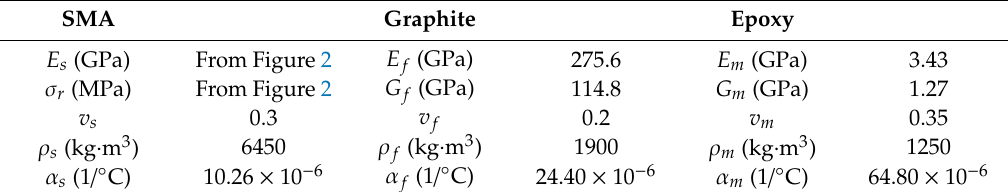
Table 1. Material properties of the shape memory alloy (SMA), graphite, and epoxy matrix.